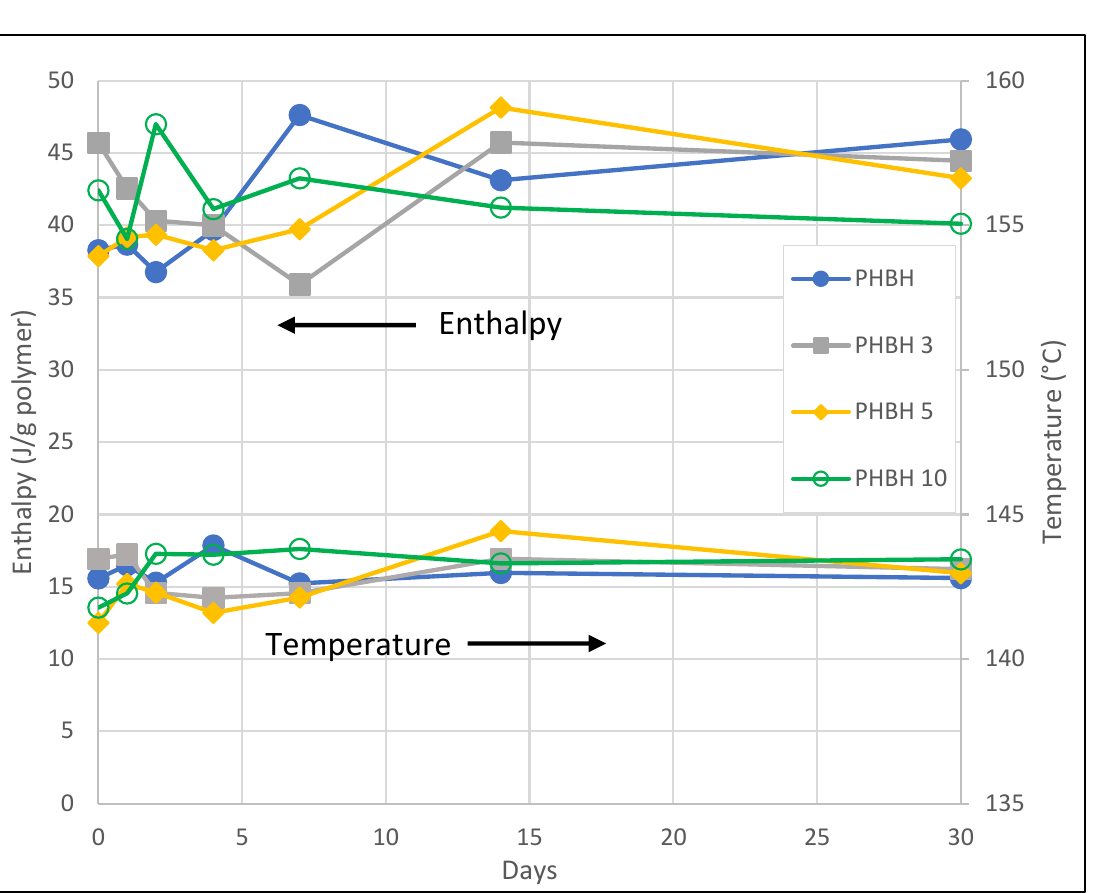
Figure 3. Evolution of the enthalpy of melting and the melting peak temperature over time for the neat PHBH and the composites processed by melt blending. The enthalpies are given per gram of polymer.